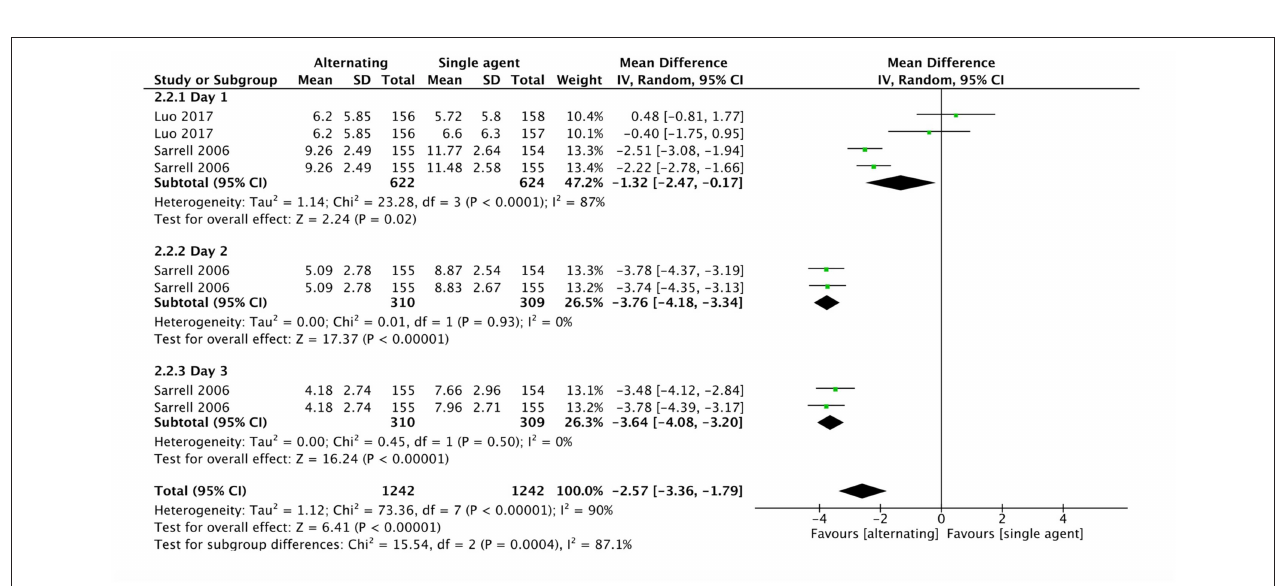
FIGURE 6 | Comparison: alternating vs. single agent, Outcome: proportion remaining febrile.